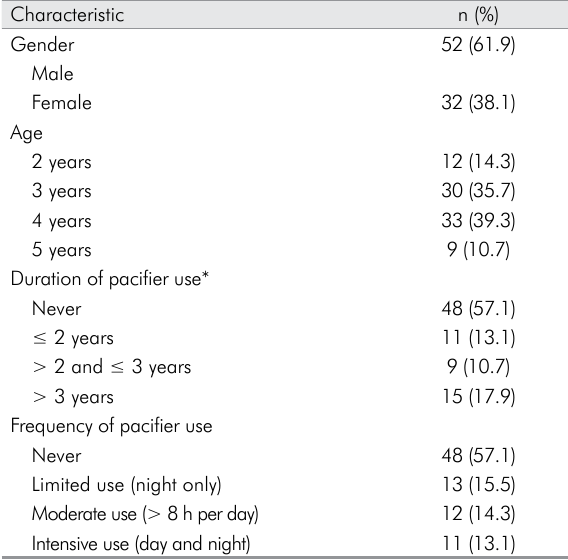
Table 1. Participant